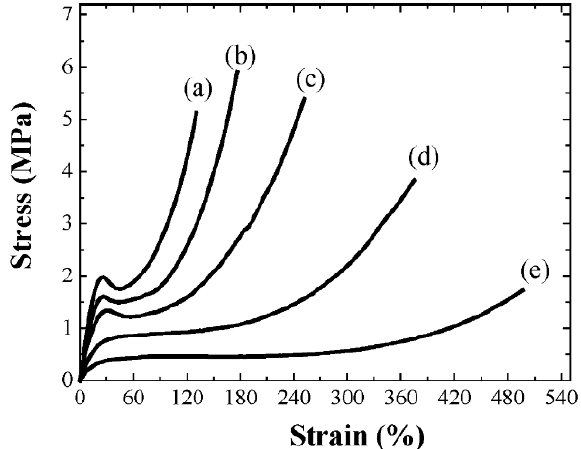
Figure 8. Dependence of elastic behavior of a rectangular piece (25 mm × 8 mm × 0.2 mm) of LCE1 on cross-linker concentration; ( a ) 25 mol %; ( b ) 20 mol %; ( c ) 15 mol %; ( d ) 10 mol %; ( e ) 5 mol % [60]. For concentrations ≥ 15%, a yield point appears in the stress-strain curve [60]. Copyright 2009 John Wiley and Sons.